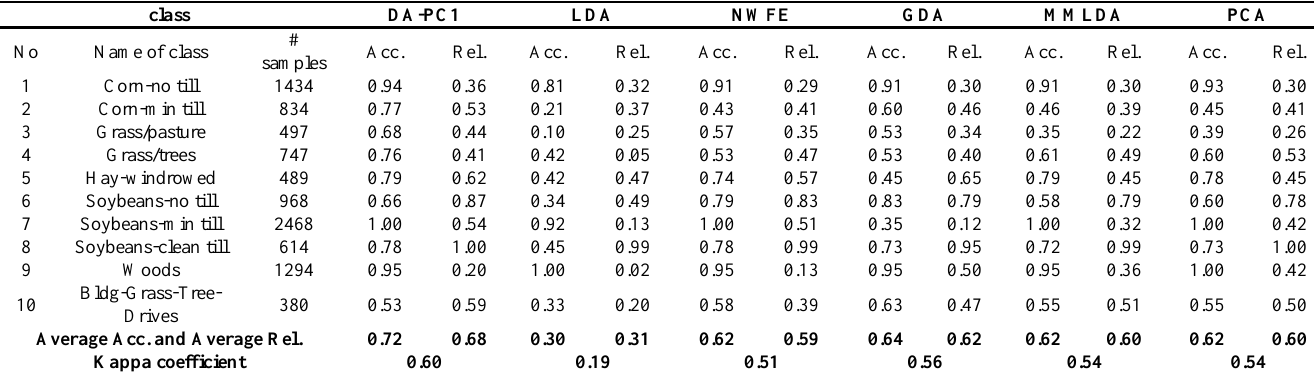
Table 1. The accuracy and reliability of classes of Indian dataset obtained by SVM classifier, 15 training samples and 6 extracted features.